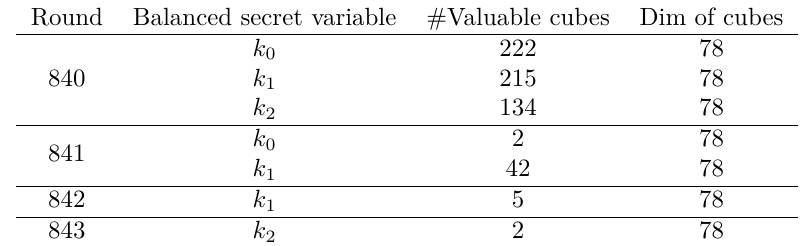
Table 1: The numbers of valuable cubes for 840-, 841-, 842-, and 843-round Trivium . Round Balanced secret